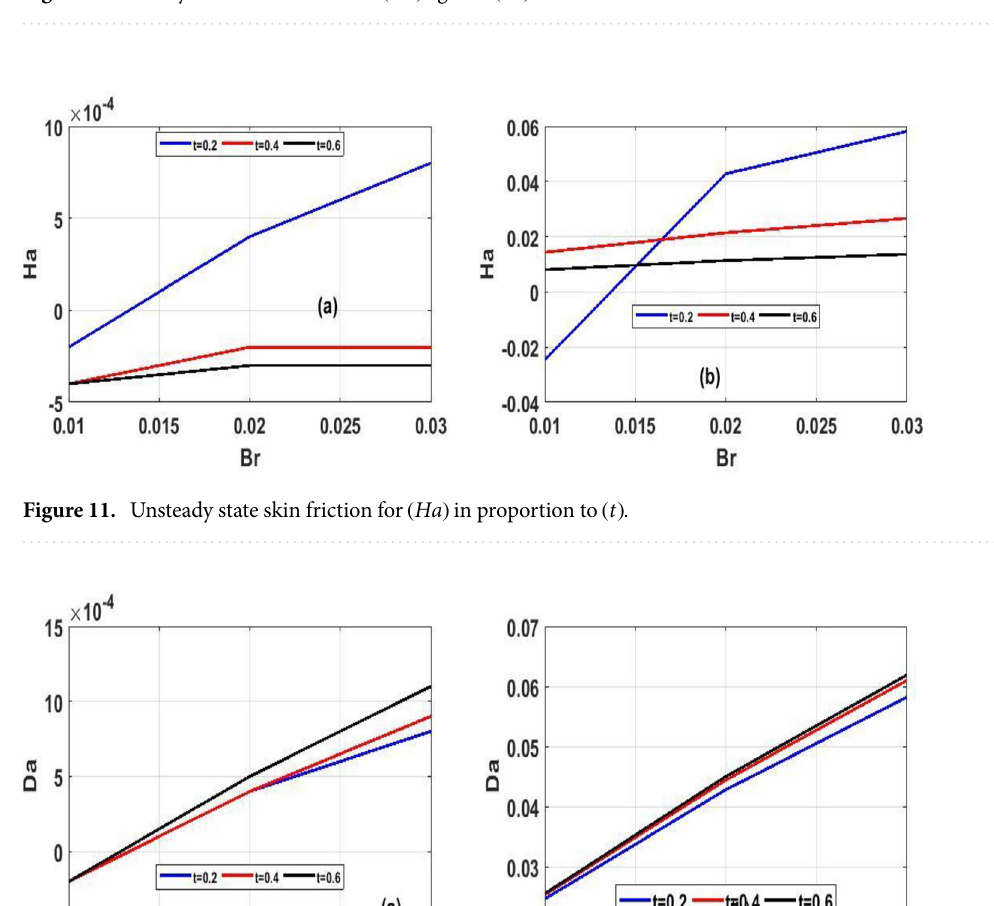
Figure 10. Steady state skin friction for ( Da ) against ( Br ) .